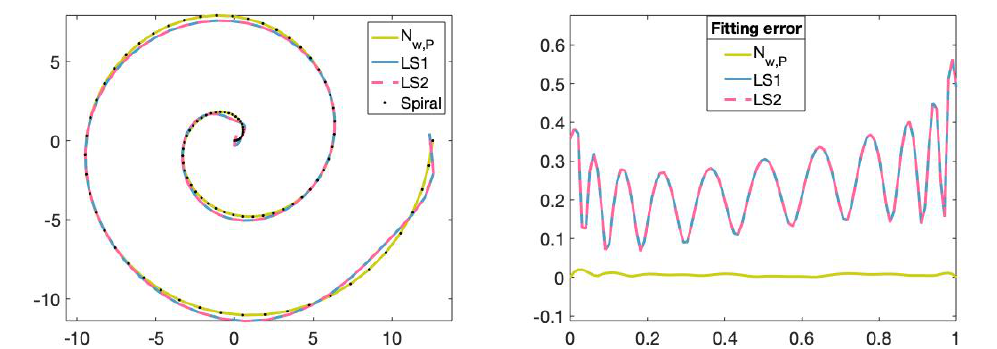
Figure 16. ( Left ): Set of points on the Archimedean spiral curve, fitting curve of degree 11 obtained with the neural network, fitting curve of degree 11 obtained with the least-squares method by using the Matlab command mldivide (LS1) and fitting curve of degree 11 obtained with the least-squares method using the Matlab command SVD (LS2). ( Right ): The x -axis represents the parameters t in [ 0,1 ] and the y -axis represents the fitting error value of the fitting curves obtained with the different